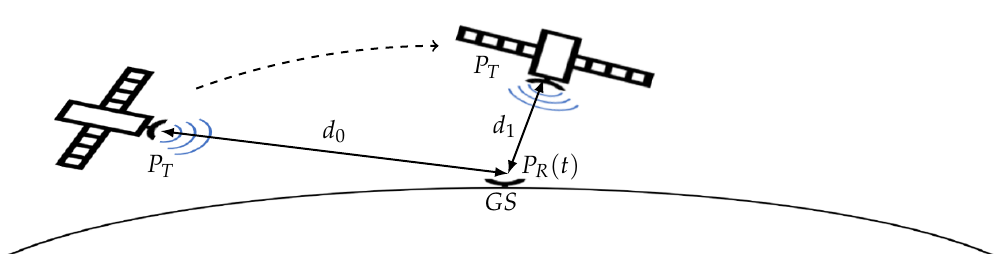
Figure 1. Communication link early in an overflight and close to the zenith.